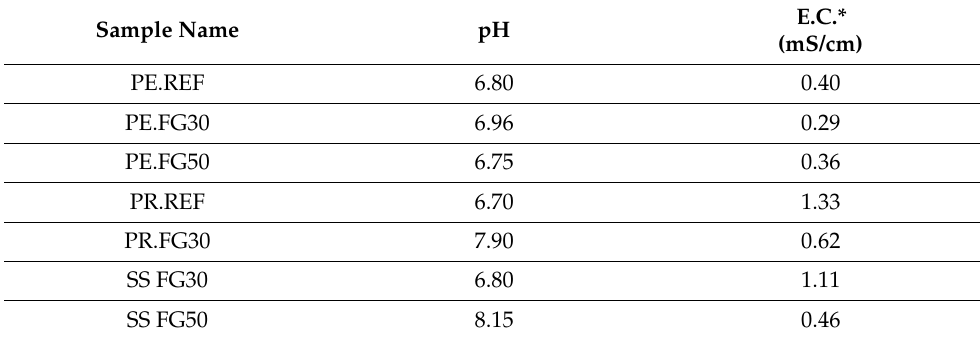
Table 3. Chemical properties of the silica porous materials obtained by the different